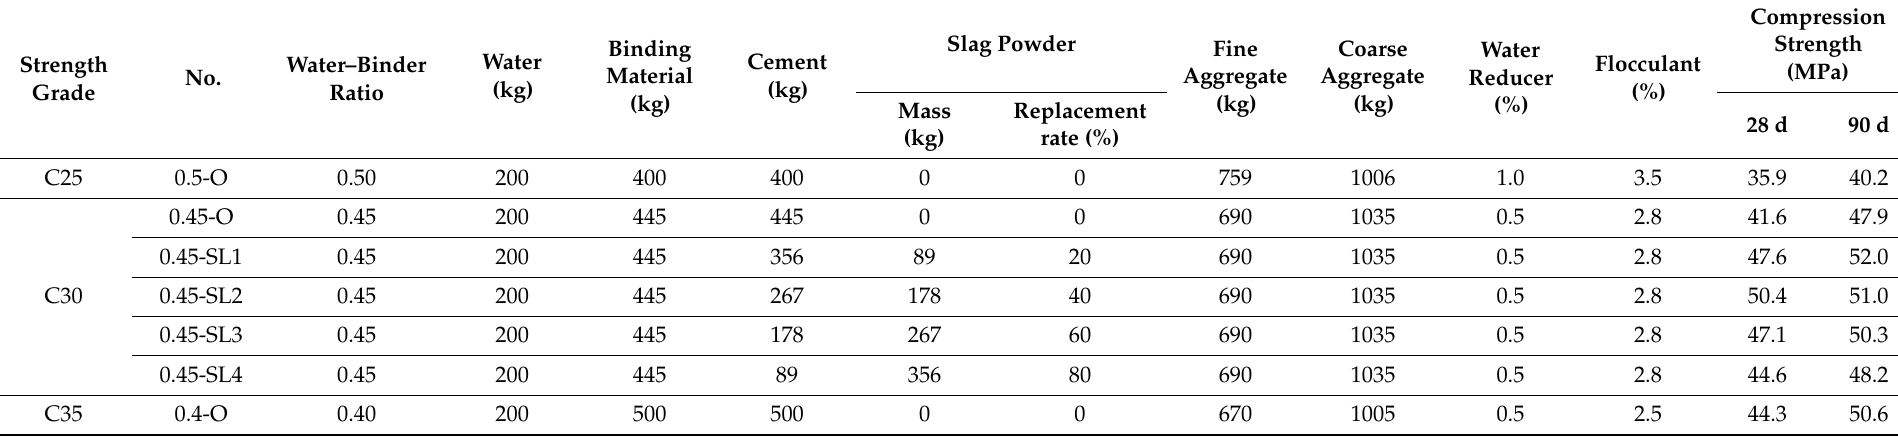
Table 2. Mixing ratio and compressive strength of